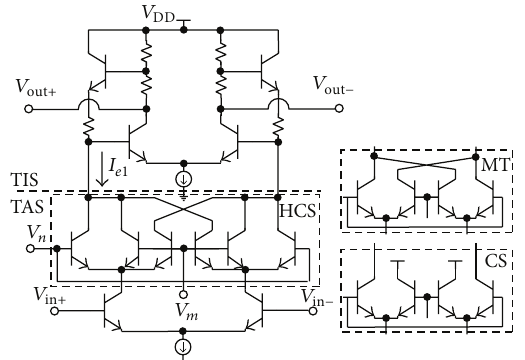
Figure 1: Proposed variable gain core with hybrid current-steering cell.